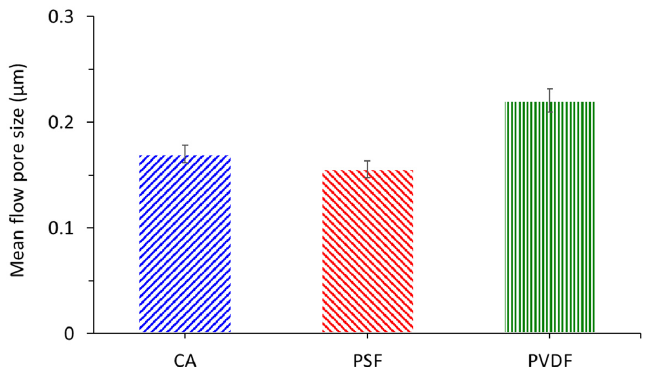
Figure 3. The pore size distribution of the developed cellulose acetate (CA), polysulfone (PSF), and polyvinylidene difluoride (PVDF) membranes.